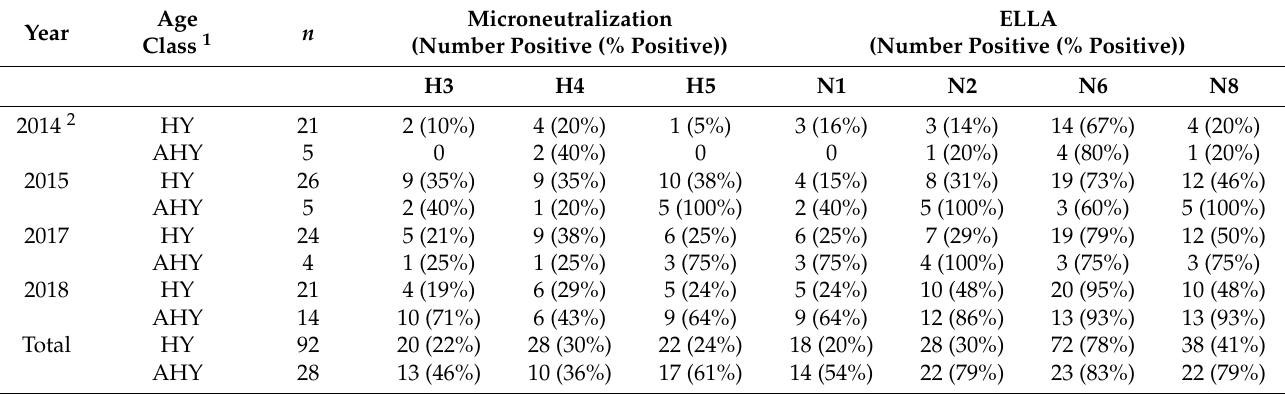
Table 3. Antibodies to hemagglutinin (microneutralization) and neuraminidase (ELLA) in sera collected from wild mallards in Northwest Minnesota, USA, by year and age